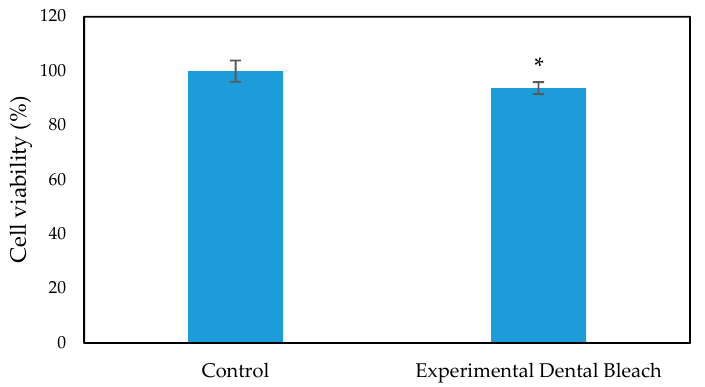
Figure 6. Cytotoxicity of the cells cultured in dental bleach-conditioned medium ( n = 6), * p < 0.05 compared to the control group by student t -test.